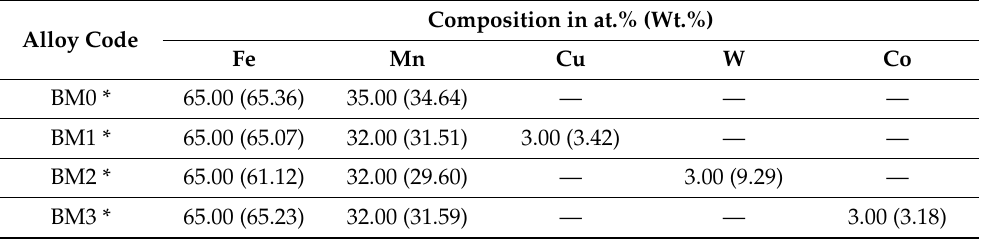
Table 1. Composition of the produced Fe-Mn, Fe-Mn-Cu, Fe-Mn-W, and Fe-Mn-Co alloys. Alloy